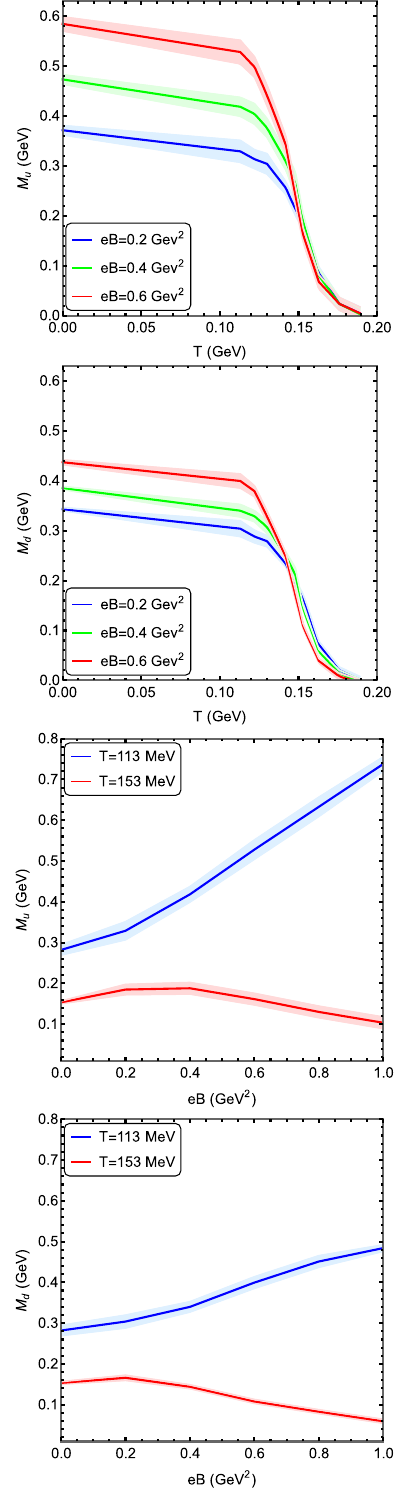
Fig. 1 Variation of the constituent quark masses ( M u and M d ) with temperature for different values of magnetic field eB = 0 . 2 , 0 . 4 , 0 . 6GeV 2 intheupperpanelsandwithmagneticfieldfordiffer- entvaluesof T = 113 , 153MeVinthelowerpanels.Thecorresponding color bands represent the estimated theoretical uncertainties due to the LQCD extractions, which for the case of M u / M d is up to maximum ∼